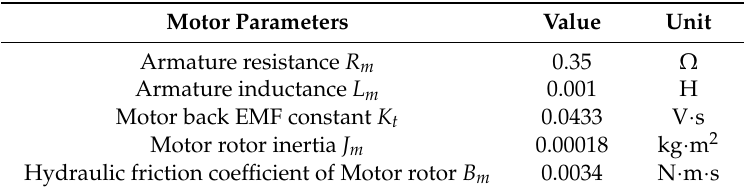
Table 1. Motor parameters used in the